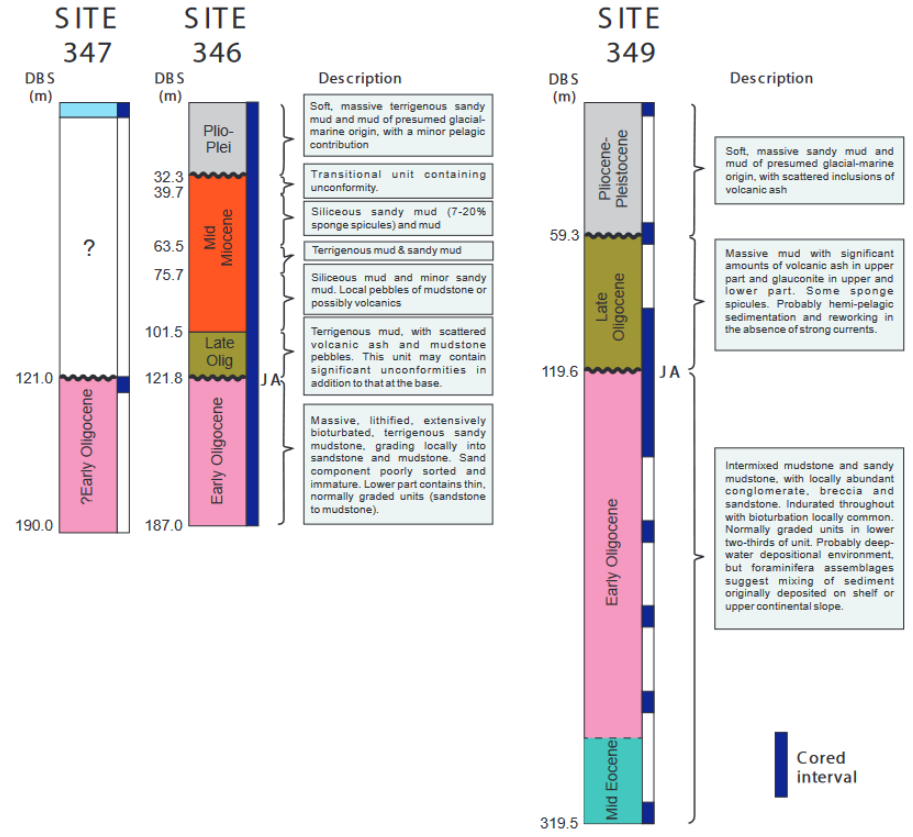
Figure 4. Summary stratigraphic profiles of DSDP Leg 38 sites 346, 347 and 349 after Talwani et al. [15], showing the position of reflector JA, updated with new biostratigraphic data presented herein. DBS = depth below sea floor.